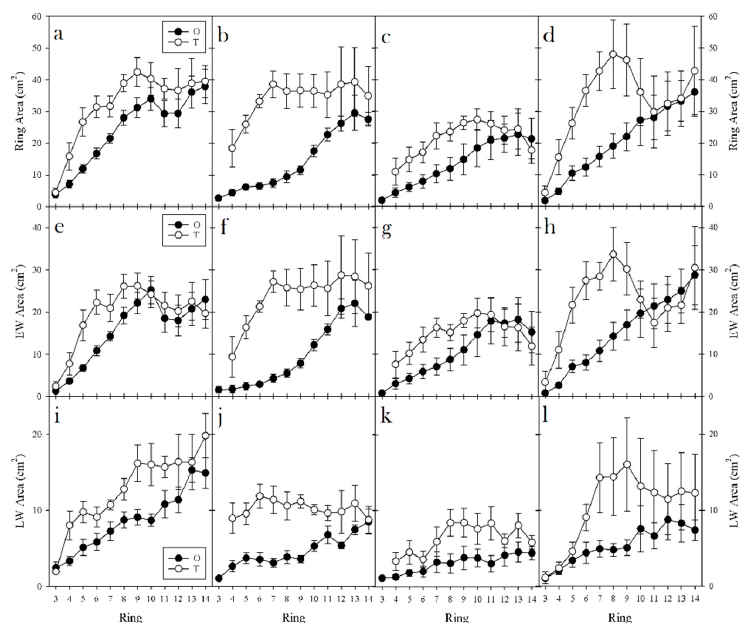
Figure 5. Ring area ( a – d ); earlywood area ( e – h ); and latewood area ( i – l ) for: Douglas-fir ( a , e , i ); western hemlock ( b , f , j ); western redcedar ( c , g , k ); and grand fir ( d , h , l ) trees growing under contrasting vegetation management treatments on a site located in the Coastal Range of western Oregon. O: no post-planting vegetation control (open symbol); T: sustained vegetation control during first five years post planting (filled symbol). Error bars represent standard error.